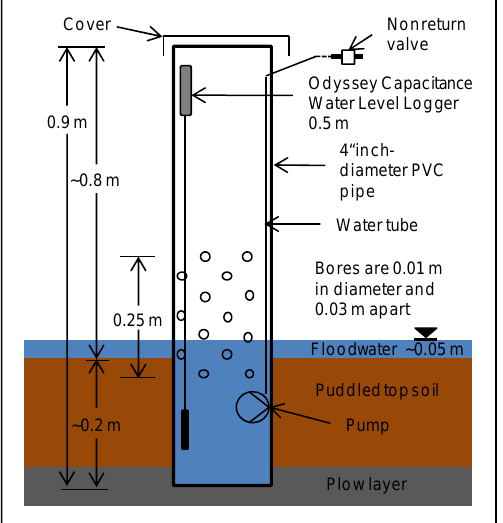
Figure 3. Surface water sampler for water sampling and monitoring of water depths in rice paddies. Each surface water sampler is equipped with a sampling pump, nonreturn valve and capacitance water logger.